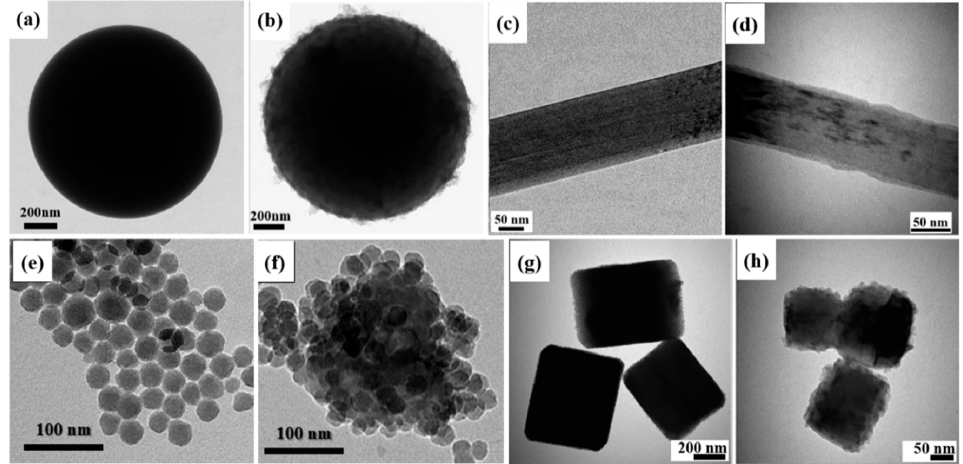
Figure 4. TEM images of ( a , b ) PS and PS / PEDOT (An et al. [87], © Elsevier, 2007); ( c , d ) nanorod-TiO 2 and nanorod-TiO 2 / PEDOT (Eroal et al. [88], © The Royal Society of Chemistry, 2015); ( e , f ) SiO 2 and PEDOT / SiO 2 (Park et al. [89], © Elsevier, 2018); ( g , h ) nanocube-TiO 2 and nanocube-TiO 2 / P3OT (Sever et al. [90], © Elsevier,